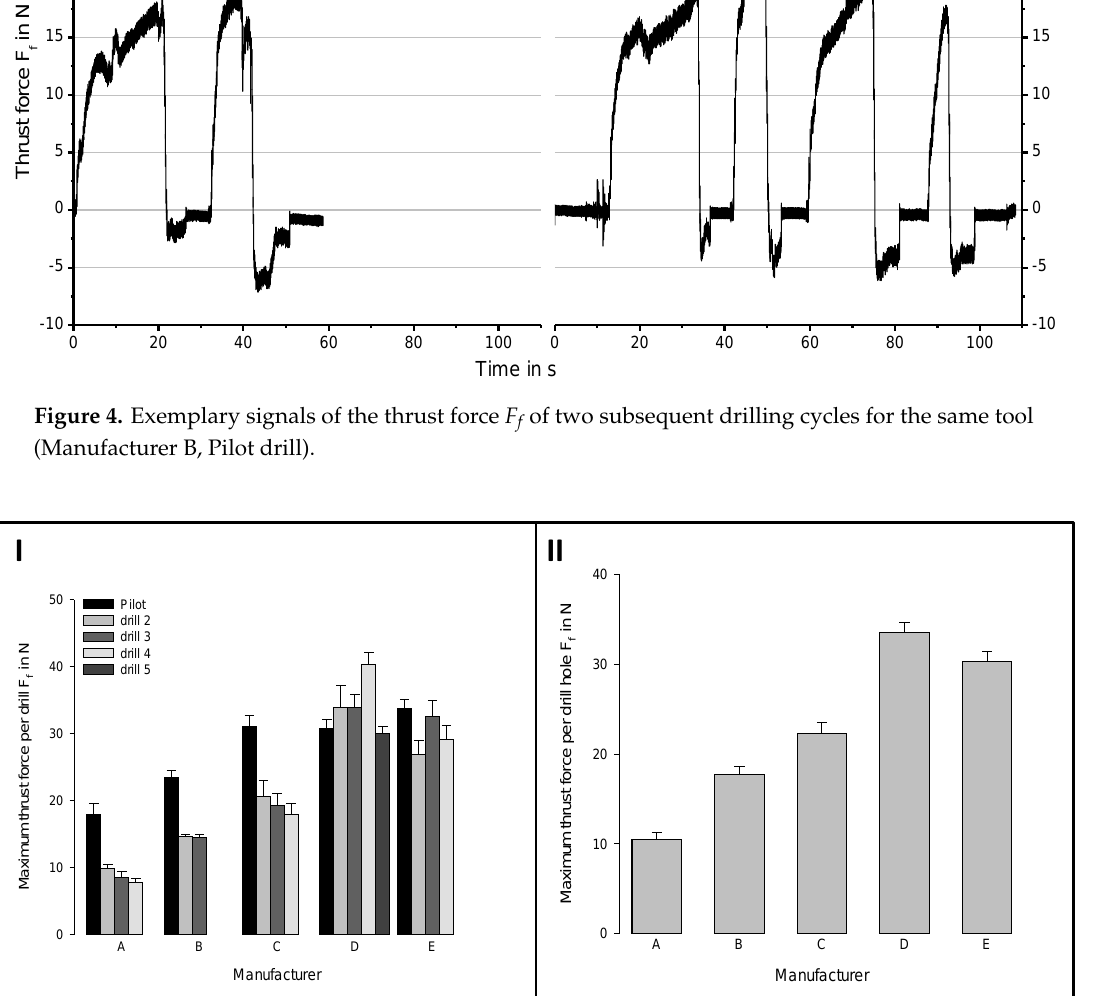
Figure 5. Maximum thrust forces ( I ) for different tools of five commercial drill sets and ( II ) for the whole sets; (mean ± SEM; n = 8).